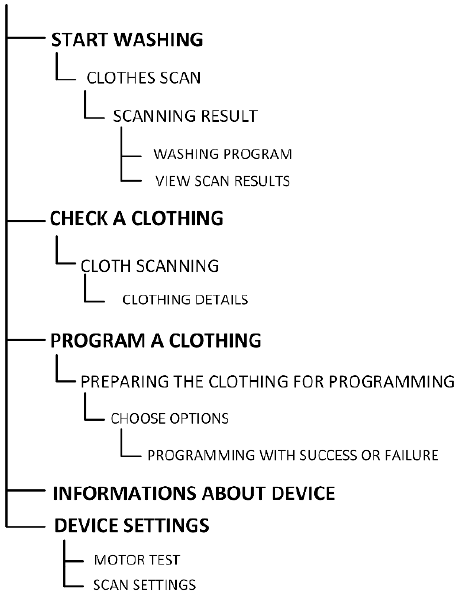
Figure A1. Structure of the software developed for the device.